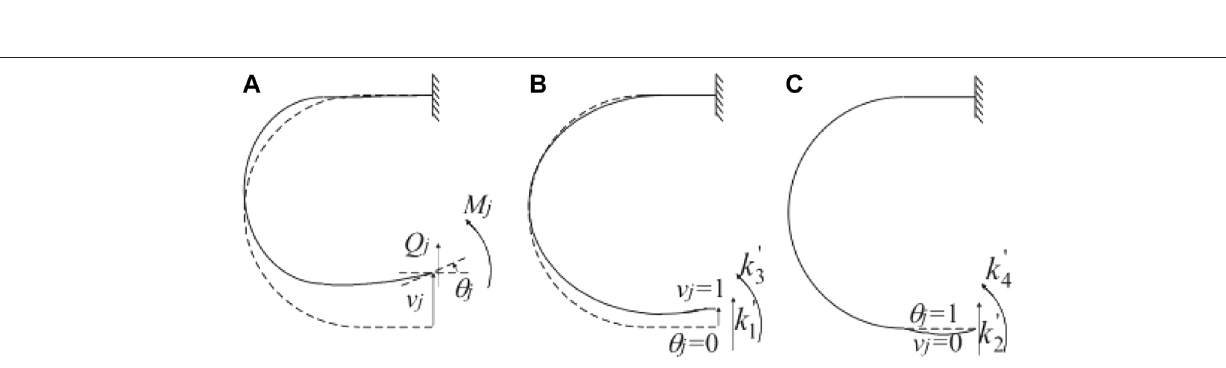
FIGURE 2 | Force by unit displacement at the member end for Model I. (A) Mechanical model, (B) force by unit vertical displacement and (C) force by unit rotation angle.